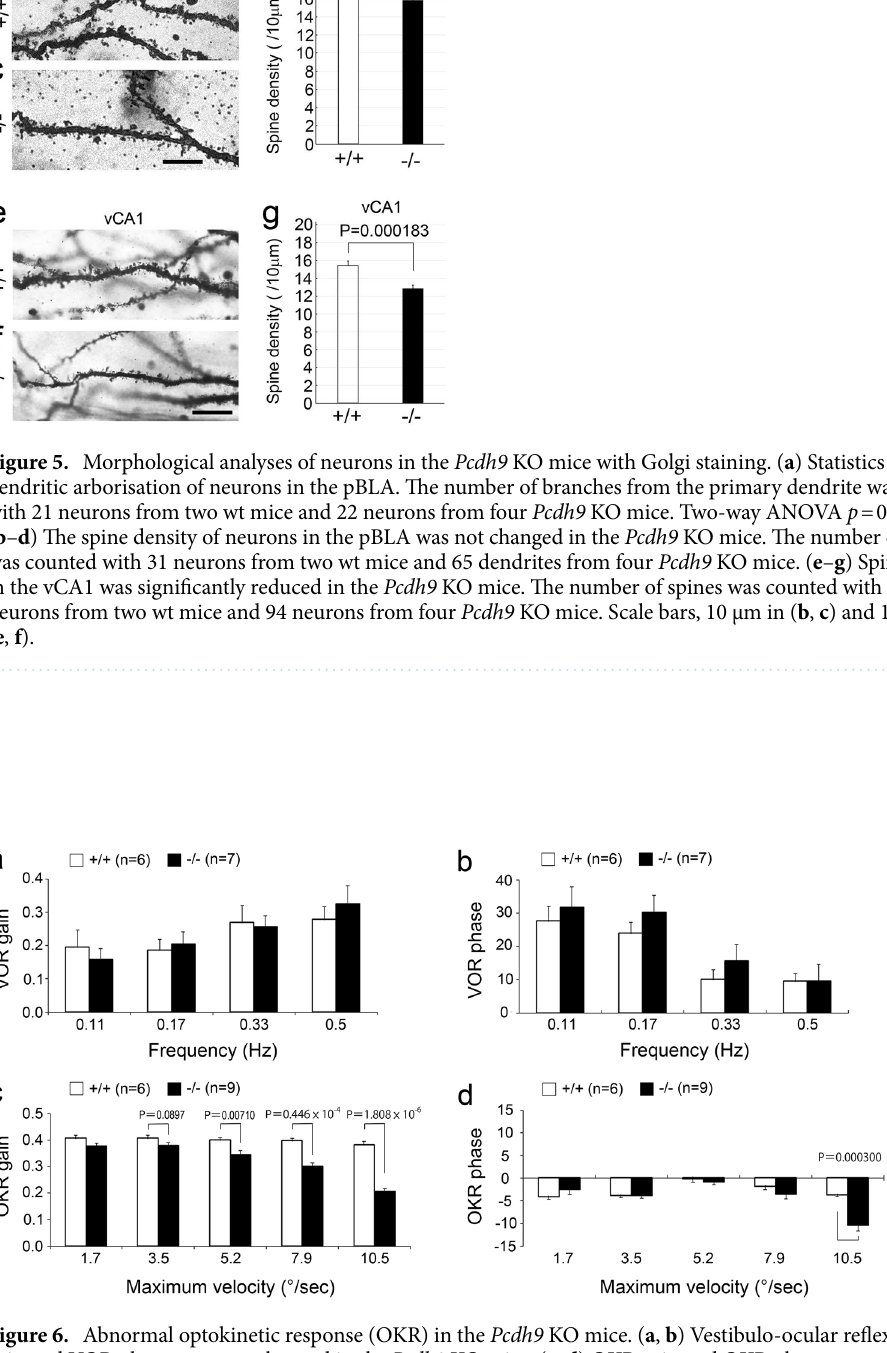
Figure 6. Abnormal optokinetic response (OKR) in the Pcdh9 KO mice. ( a , b ) Vestibulo-ocular reflex (VOR) gain and VOR phase were not changed in the Pcdh9 KO mice. ( c , d ) OKR gain and OKR phase were reduced at the higher maximum velocities in the Pcdh9 KO mice. Scale bar, 2